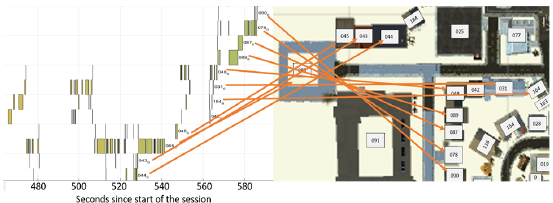
Figure 9: Excerpt out of a timeline of a full session. Represents houses on the x-Axis (Names are numbers between 001 and 200 + a rotation of 0, 3 or 6). Yellow blocks represent timespans dur- ing which a certain house was looked at. Orange arrows point to the house on the map.